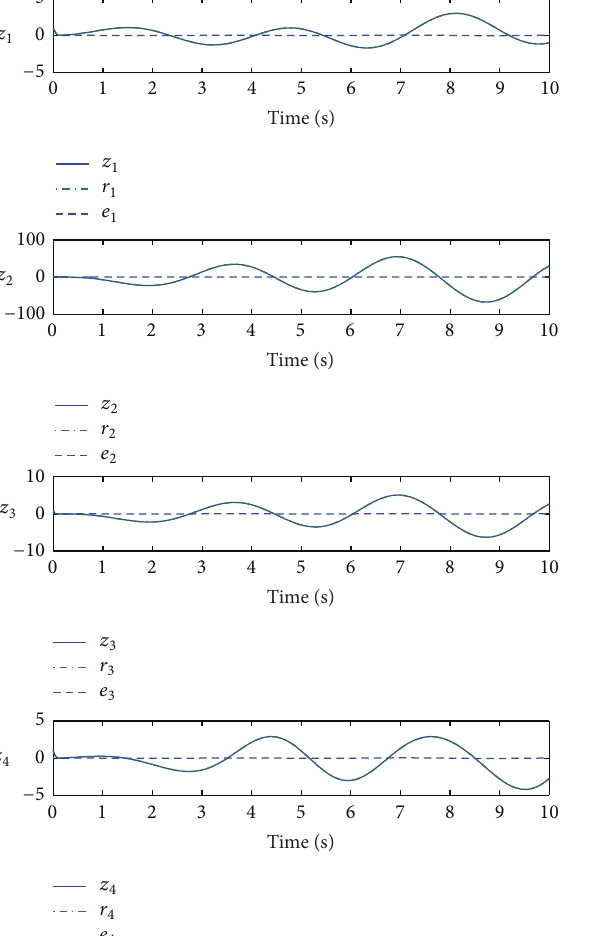
Figure 8: Controlled output 𝑧 , reference 𝑟 , and tracking error 𝑒 .